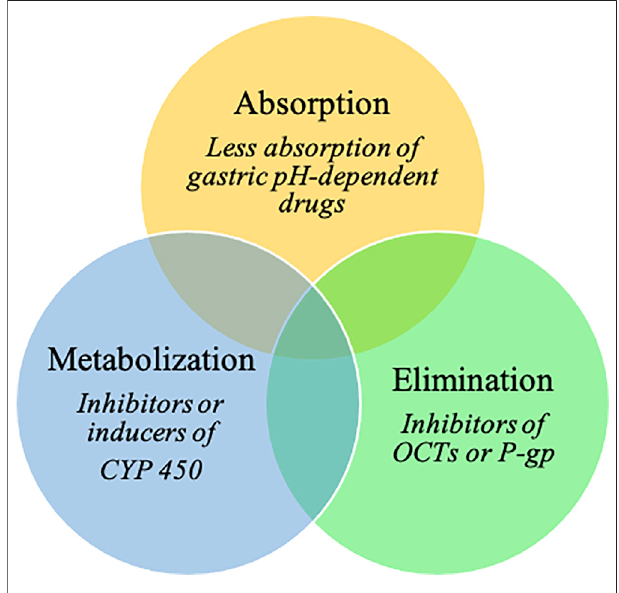
FIGURE 1 | Pharmacodynamic mechanisms of PPIs drug-drug